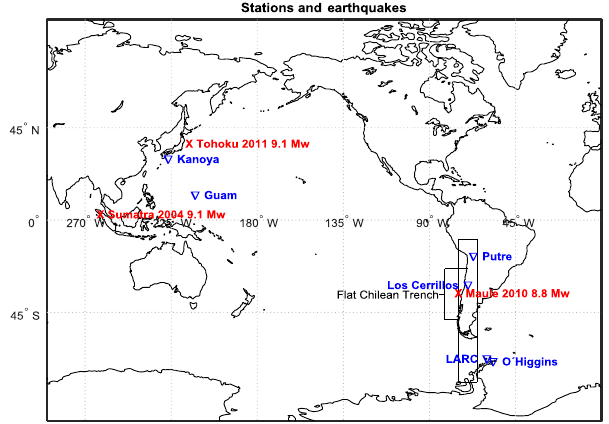
Figure 1. Observatories map of magnetometers and cosmic rays (blue triangles): the OP, OLC, LARC, O’Higgins Geomagnetic Ob- servatory (OH), Guam (GUA) and Kanoya (KNY). A red X marks the earthquake events (Sumatra, Maule, Japan) with M w above 8.8. (2004–2011). Rectangle represents the area covered by cutoff rigid- ity study. The smaller left rectangle indicates the flat Chilean